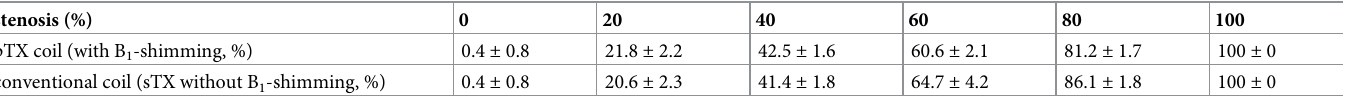
Table 2. Results of stenosis diameter analysis [mm] using single transmission (sTX) and parallel transmission (pTX) imaging ( n = 15 per type of stenosis). Data are mean ± standard deviation. stenosis (%) pTX coil (with B 1 -shimming, %) conventional coil (sTX without B 1 -shimming, %)